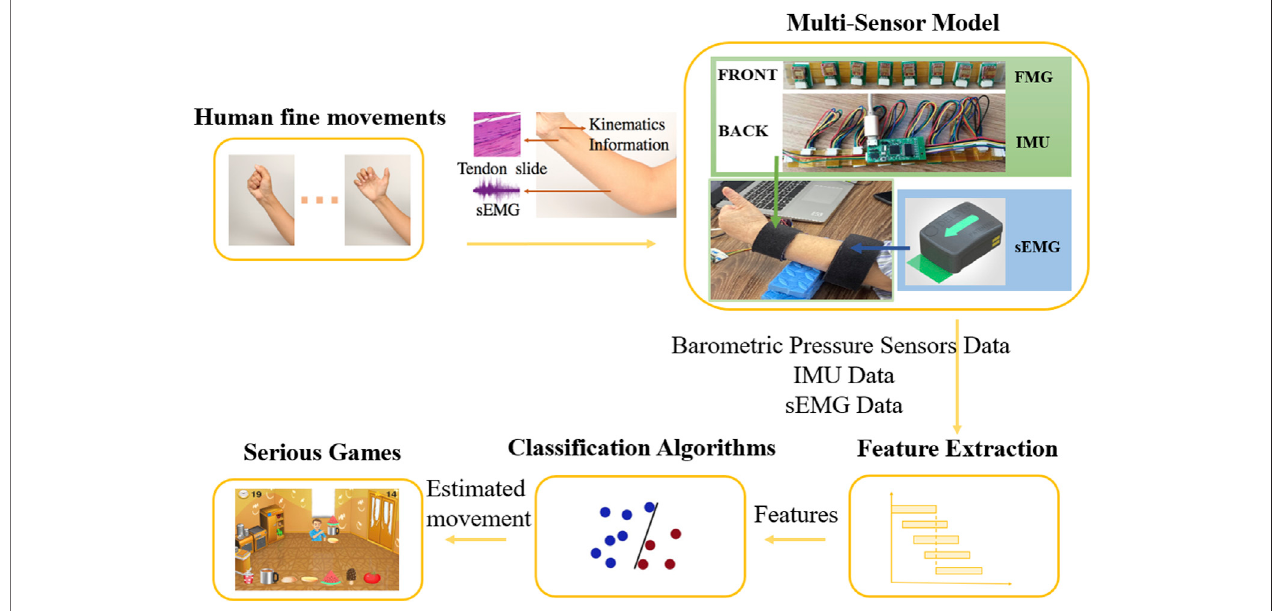
FIGURE 1 | Wearable multimodal-serious game rehabilitation approach developed to improve upper extremity motor function and cognitive function after stroke. Patients performed 12 different ADLs-related fi ne movements. Kinematics data, morphology pro fi le changes around the wrist and EMG data of forearm were extracted via IMU, FMG sensors and EMG sensors. Effective features were extracted from data after pre-processing and were put into classi fi cation algorithms. Two serious gameswere developed, and the predicted movementwas used asinput for the games, allowing the patients to interact with the targets in thegameand get vision and sound